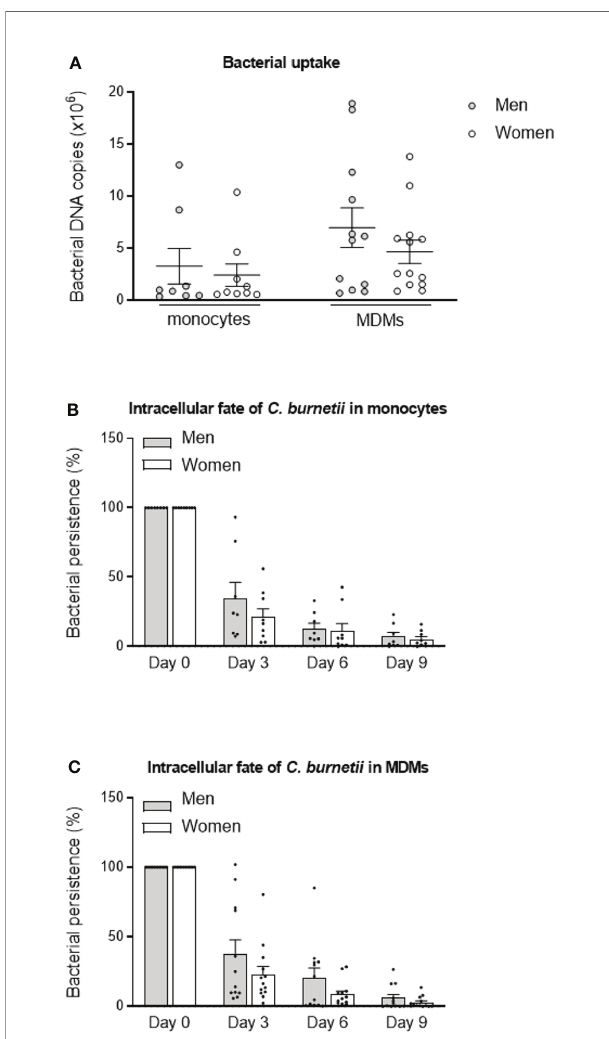
FIGURE 1 | C. burnetii uptake and persistence. (A) Monocytes from healthy donors from males (n=8) and females (n=9) and MDMs (12 males and 13 females) were infected with C. burnetii (50 bacteria per cell) for 4 hours. The number of bacterial DNA copies within cells was determined by qPCR. The tests were performed in duplicate for each individual. After the bacterial uptake phase (designated day 0), (B) monocytes and (C) MDMs were cultivated for 9 days, and the presence of bacterial DNA copies was assessed every 3 days. The bacterial fate at day 3, 6 and 9 was calculated in percentage relative to day 0. Data for men (in grey) and female (in white) represent mean ± standard error of the mean (duplicate was performed for each individual). Statistical analyses were performed using Mann-Whitney U test (men vs.